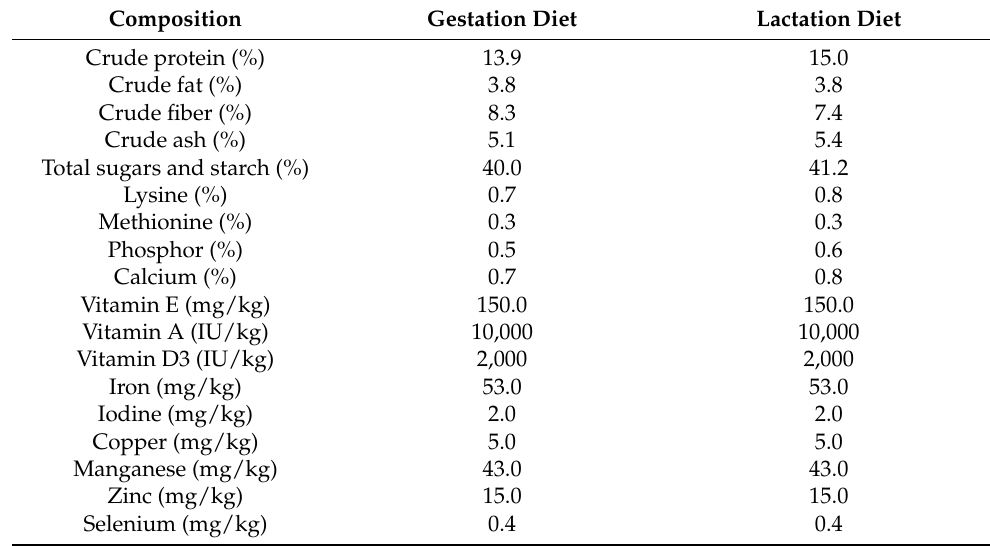
Table 1. Nutrient and chemical composition of sows’ gestation and lactation diets.